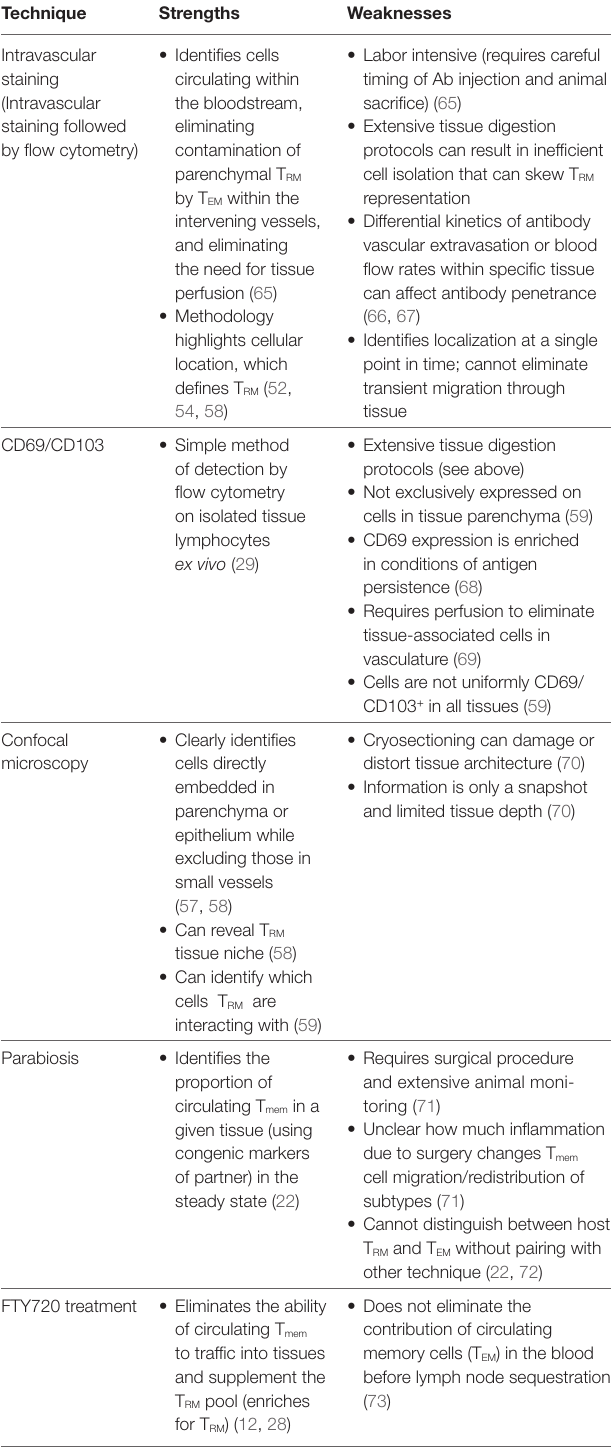
tabLe 1 | Common methods used for the identification of T RM cells in peripheral